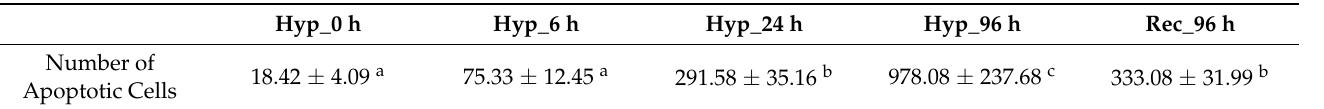
Table 3. Number of intestinal apoptotic cells of largemouth bass under hypoxic stress followed by 96 h of